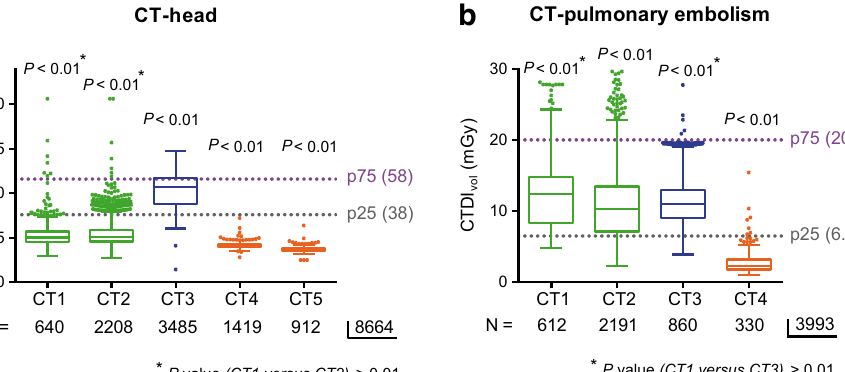
other CT system. b Box plot of the CTDI vol -median value, interquartile range, total range and outliers for all CT-pulmonary embolism examina- tions on four CTsystems with the national P75 and P25 DRLs as bench- mark, showing the CTDI vol is not statistically different ( p value of CT1 versus CT3 ≥ 0.01) between CTsystem 1 in hospital A and the CTsystem in hospital B. All other P values (< 0.01) are the result of comparing the mean rank of each CT system with the mean rank of each other CT system. Kruskal-Wallis test with post-hoc Dunn test